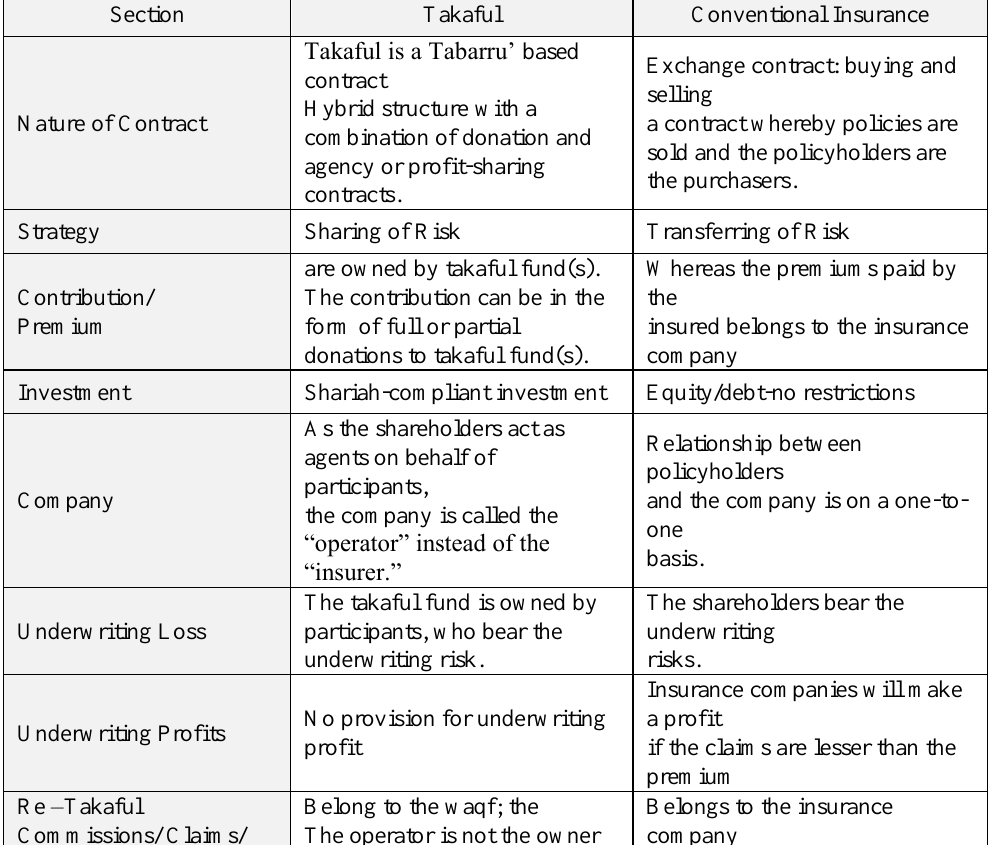
Table 2. The Deference Between Takaful and Conventional